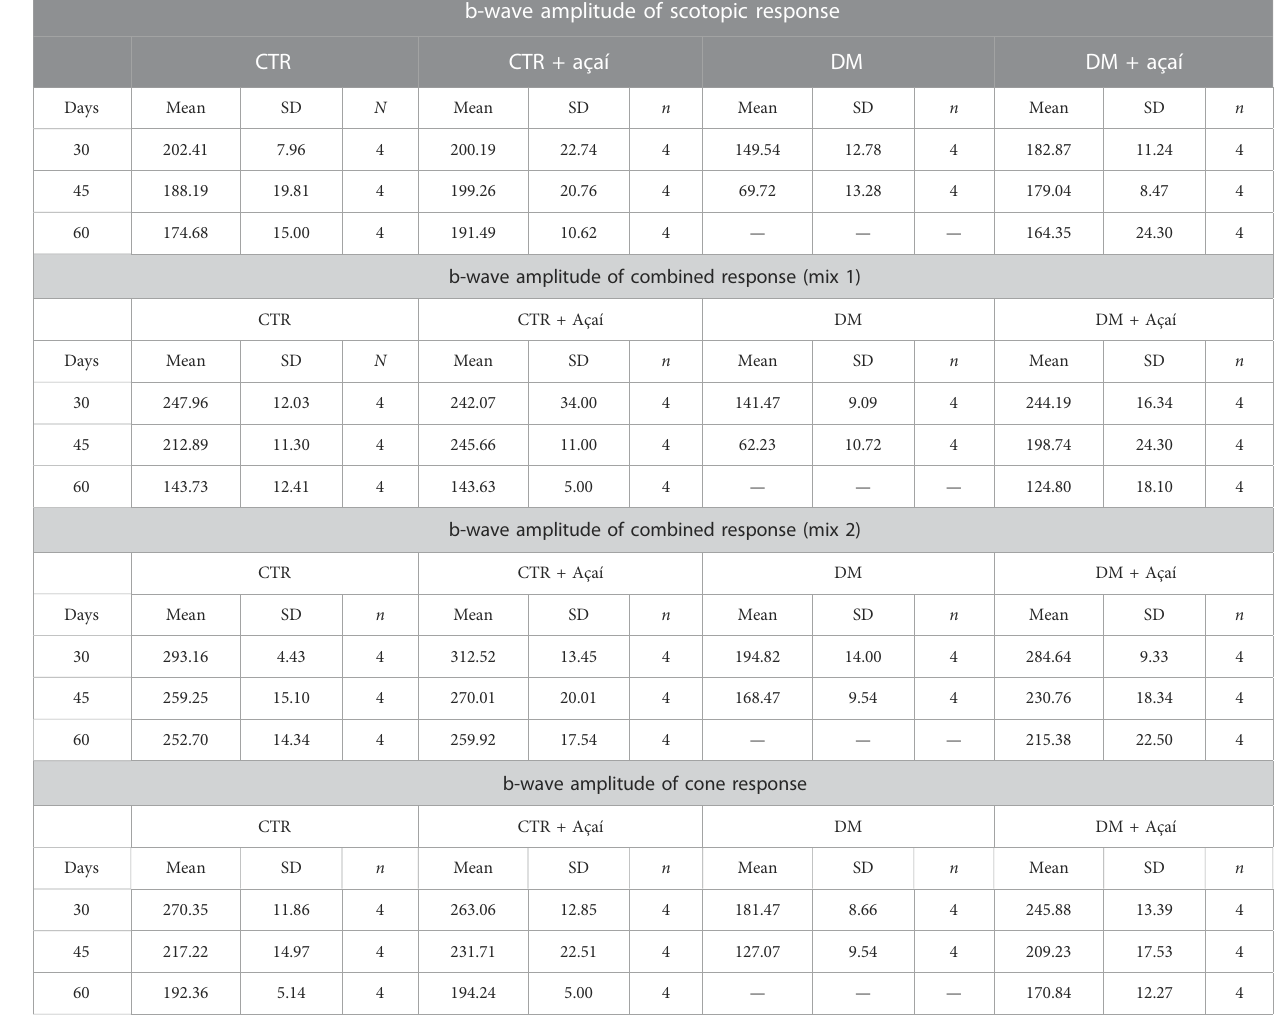
TABLE 1 Amplitudes responses compilation from b-wave by all ERG